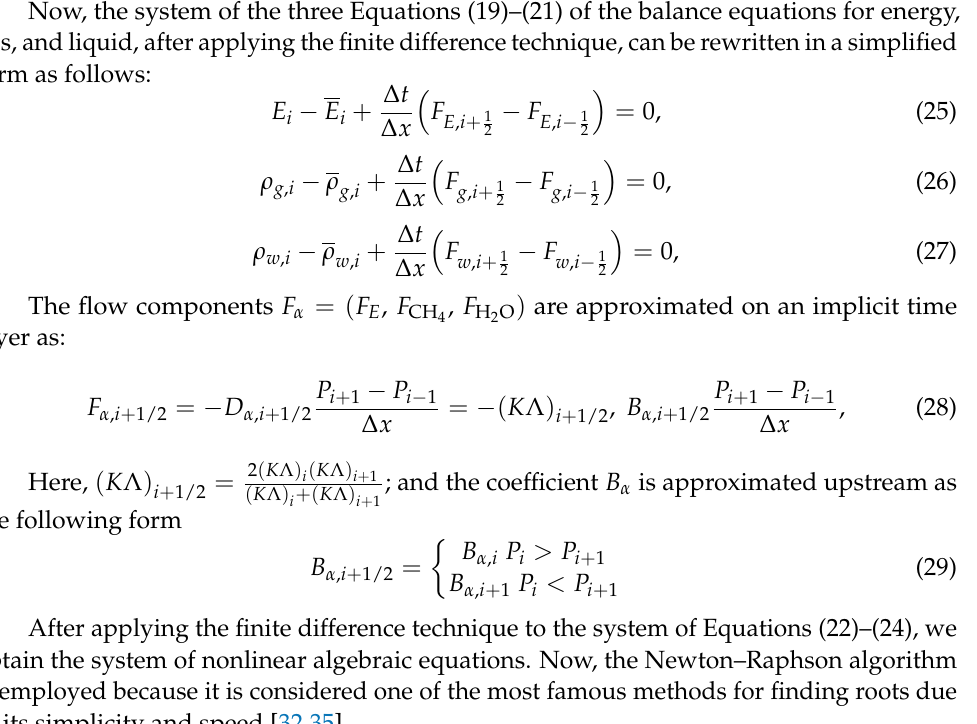
Figure 2. Schematic diagram of the initial and boundary conditions of the hydrate decomposition in a one-dimensional model.